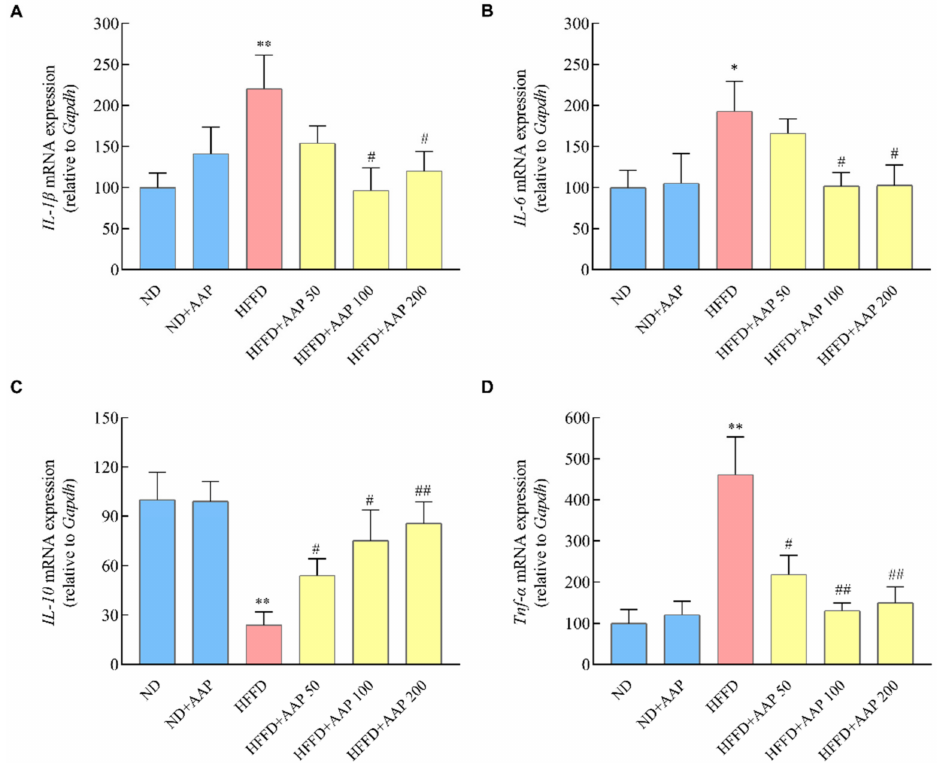
Figure 7. Effects of Auricularia auricula-judae polysaccharides on liver inflammatory response in HFFD-induced obese mice. The mRNA levels of inflammatory response including ( A ) IL-1 β , ( B ) IL-6 , ( C ) IL-10 , ( D ) TNF- α . The data are presented as the mean ± SEM, n ≥ 6, * p < 0.05, ** p < 0.01, vs. ND group, # p < 0.05, ## p < 0.01 vs. HFFD